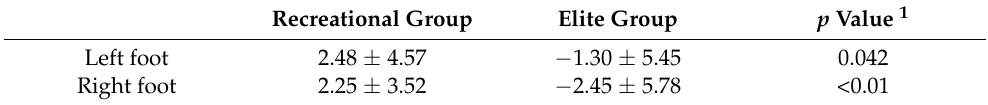
Table 5. Static Rearfoot Postural Alignment.